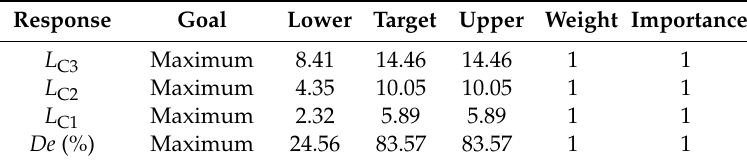
Table 4. Goals and parameter range for optimization of deposition levels.